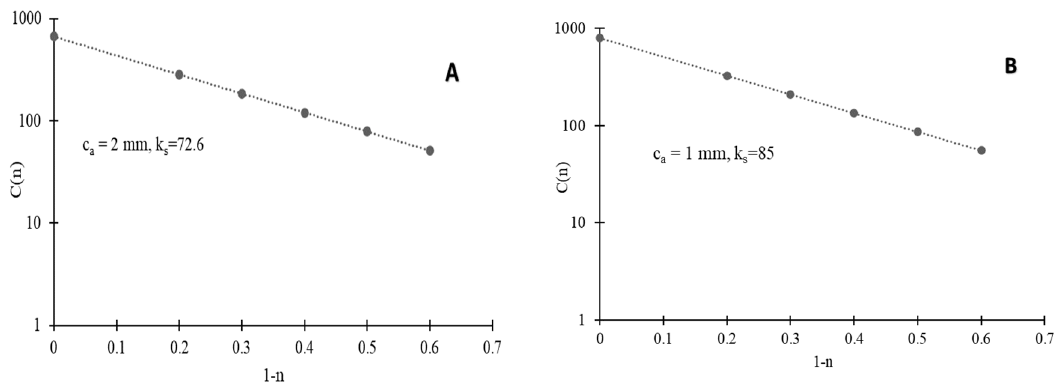
Figure 10. Determined k s values for the power-law case through simulations; ( A )— c a = 2 mm, ( B )— c a = 1